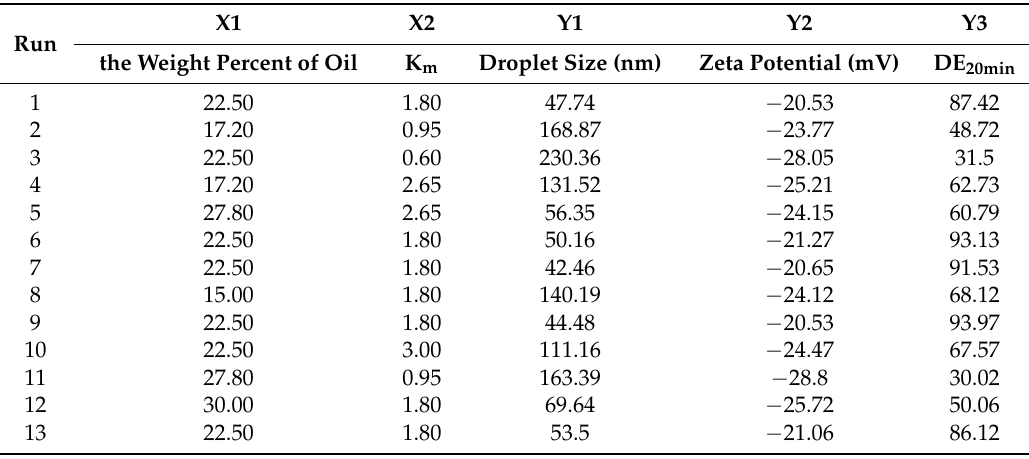
Table 2. Experimental runs and results of central composite